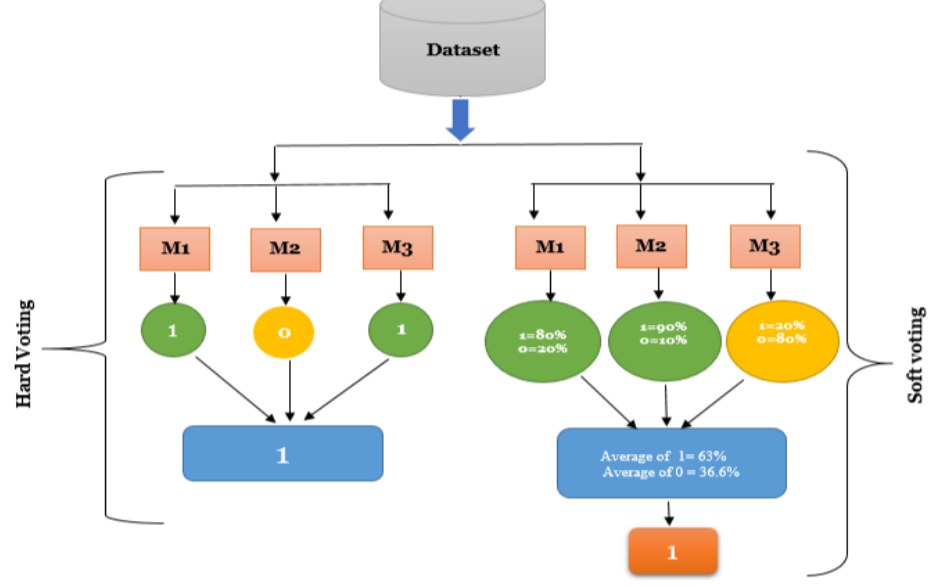
Figure 3. Majority Voting Methods .